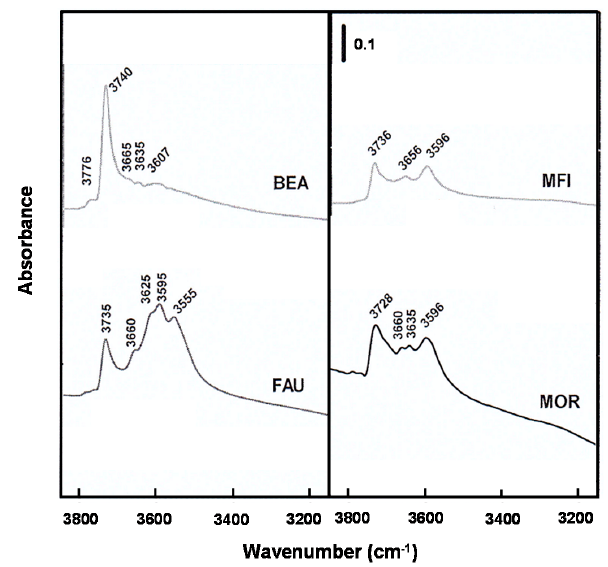
Figure 4. FT ‐ IR spectra of the zeolites. Figure 4. FT-IR spectra of the